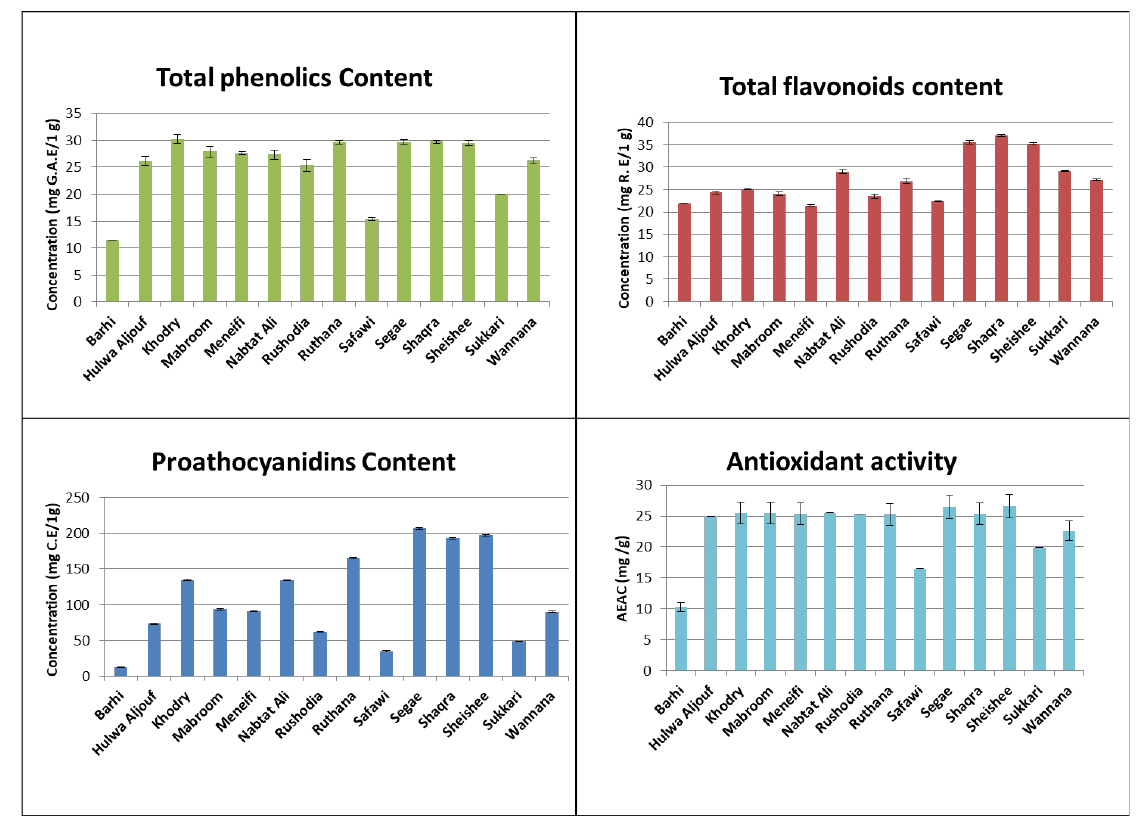
Figure 1. Total phenolics, total flavonoids, and proanthocyanidins contents and antioxidant activity of fourteen varieties of date pits extracts [Values are represented in mean ± S.E.M ( n = 3); total phenolics content (TPC) was expressed as mg gallic acid equivalents in 1 g of dried extract (mg GAE/g); total proanthocyanidins content (PAC) was estimated as mg of catechin equivalent (mg CE)/g of the crude extract; total flavonoids content (TFC) was estimated as mg rutin equivalents in 1 g of dried extract (mg RE/g). DPPH free radical scavenging activity was expressed as mg ascorbic acid equivalent antioxidant capacity (AEAC) in 1 g of dry extract].